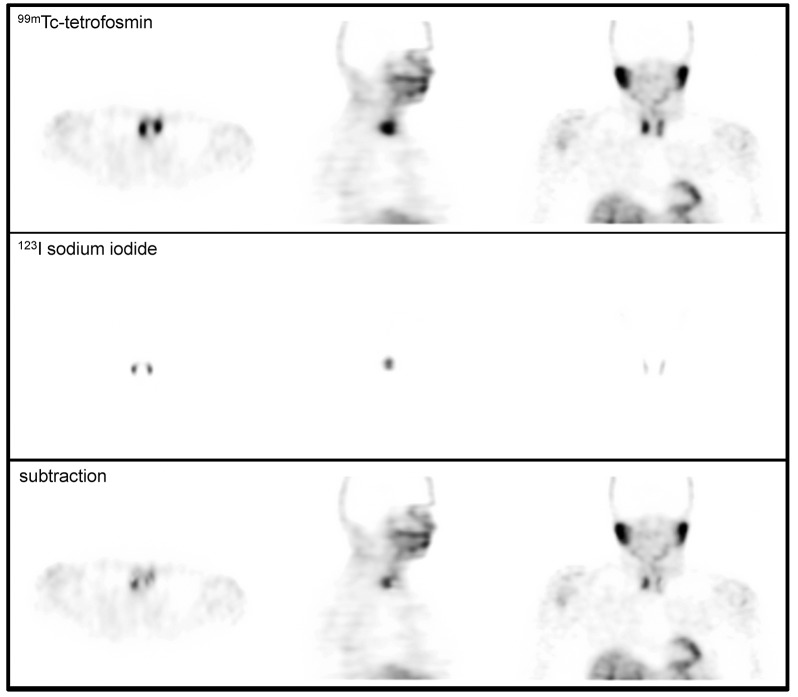
Example of dual-isotope 99mTc-tetrofosmin and 123I sodium iodide single-photon-emission-computed-tomography (SPECT).
123I sodium iodide image (middle panel) was semi-manually normalized to 99mTc-tetrofosmin image (upper panel) and afterwards subtracted from it (lower panel). Adenoma was detected at the right lower pole of the thyroid and patient received minimal invasive surgery (duration of surgery 90 minutes).